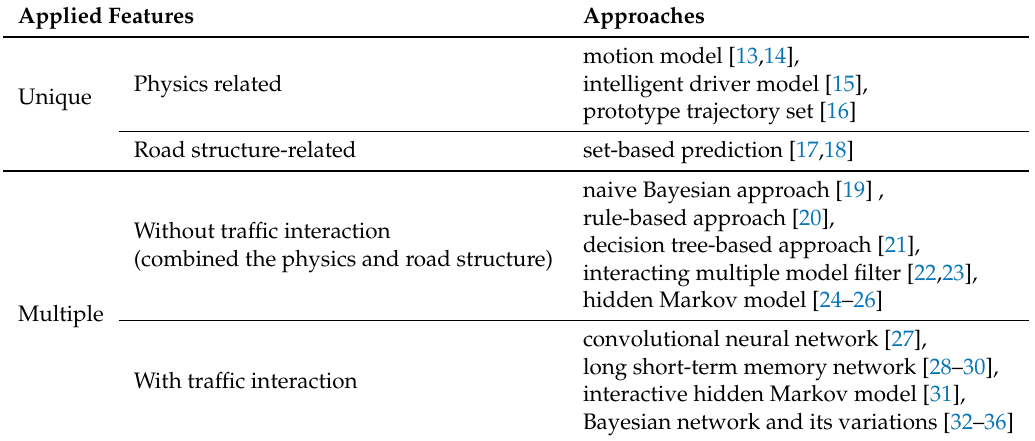
Table 1. Comparative review of approaches on intention recognition for surrounding